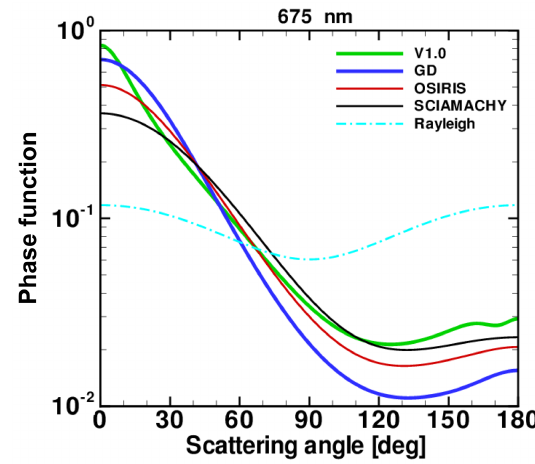
Figure 2. Phase functions at the 675nm wavelength derived from the aerosol size distributions listed in Table 1, including OMPS V1.0 (green), GD (blue), OSIRIS (red) and SCIAMACHY (black). The Rayleigh phase function is also shown as a dashed line for ref- erence. The V1.0 P((cid:50)) is closer to Rayleigh behavior at large scat- tering angles despite having more coarse particles ( r > 0 . 5µm) than others. This is because phase function at 675nm is sensitive to par- ticle radii at